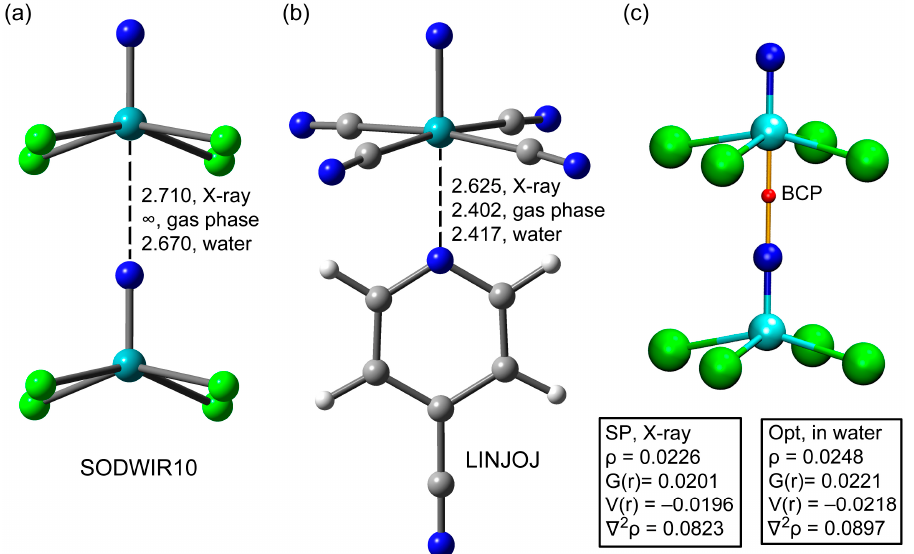
Figure 12. ( a ) Optimized structure of SODWIR10 in water. Distances in Å. ( b ) Optimized structure of LINJOJ in water. Distances in Å ( c ) QTAIM analysis of the optimized dimer SODWIR10. The values of density ( ρ ), Lagrangian kinetic energy density G(r), Potential energy density V(r), and the Laplacian of the electron density ∇ 2 ρ are given in atomics units for the single point (SP) of the X-ray geometry and the optimized (Opt) in water. The QTAIM parameters are in